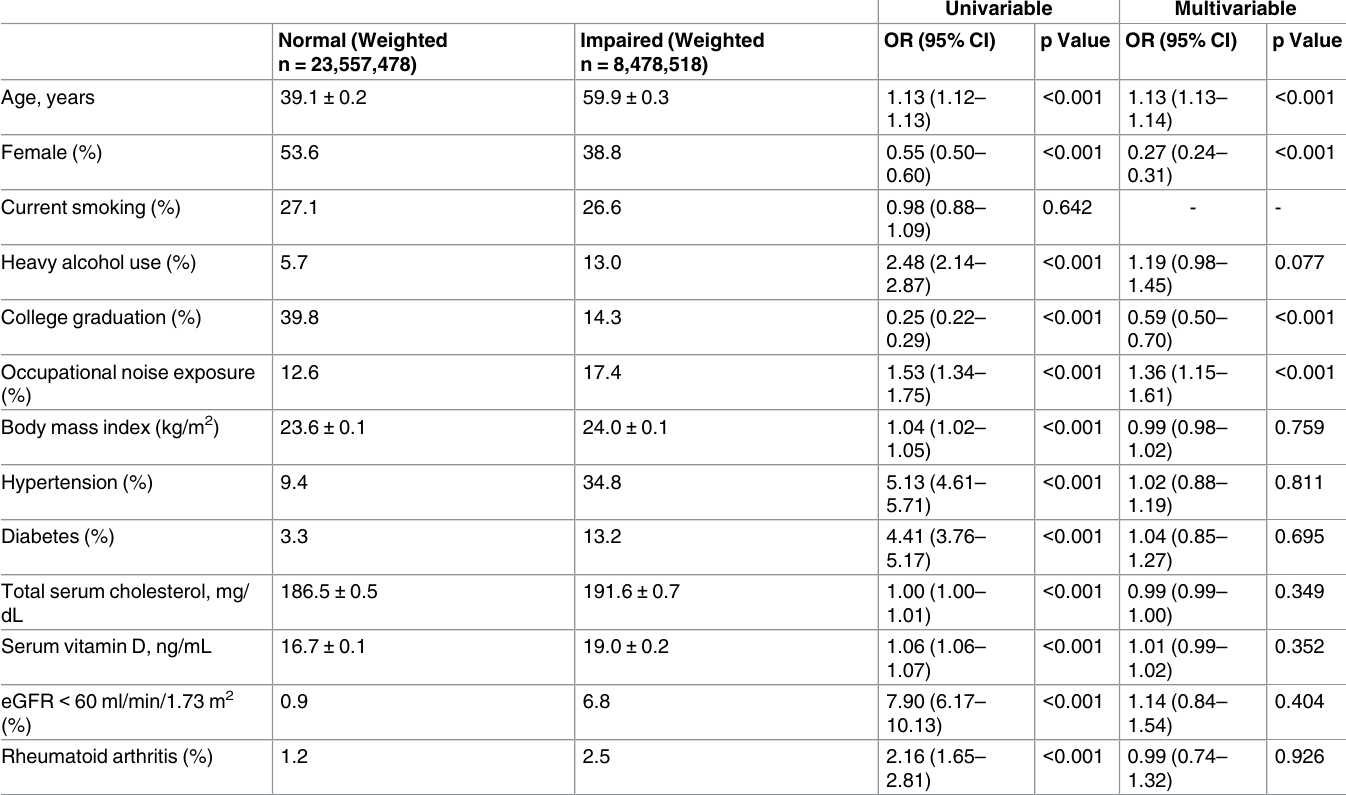
Table 4. Logistic regression analysis to predict risk of high-frequency hearing impairment in the Korean adult